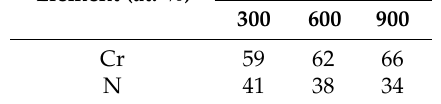
Table 1. WDS measurements obtained for the Cr x N coatings at various pressures. Element (at. %)